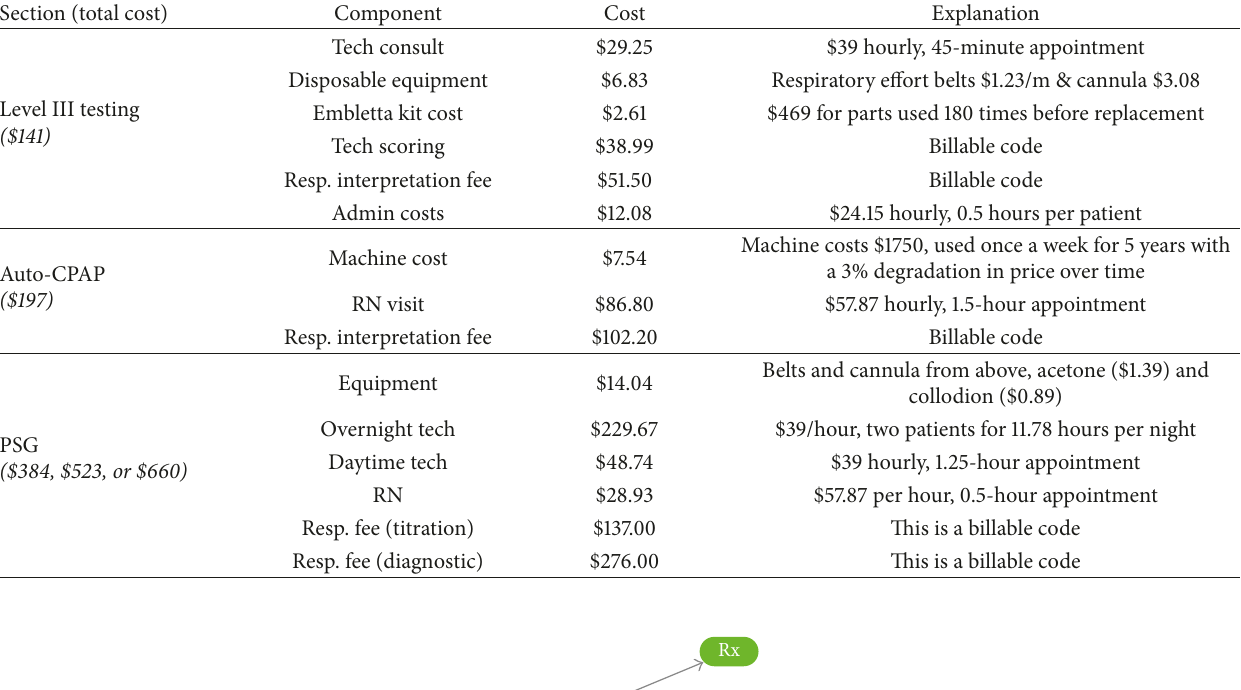
Table 1: Costs within the sleep lab program at the SHR. All prices are reported in 2014 Canadian Dollars. The variability of PSG costs is because some patients get their titration and diagnosis on two separate nights, while others get it done in one night (a “split-night” visit).